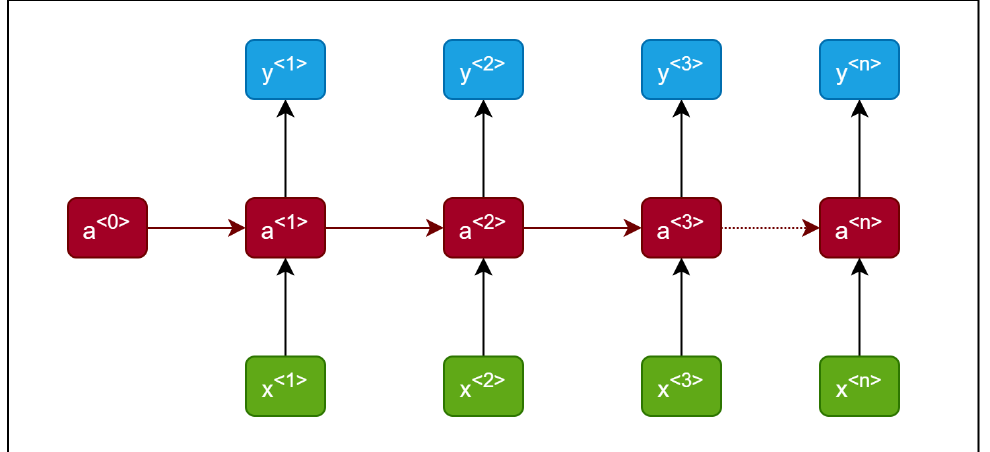
Figure 4. Overview of the RNN architecture [54] illustrating the flow of input (x), output (y), and activation function (a) at each